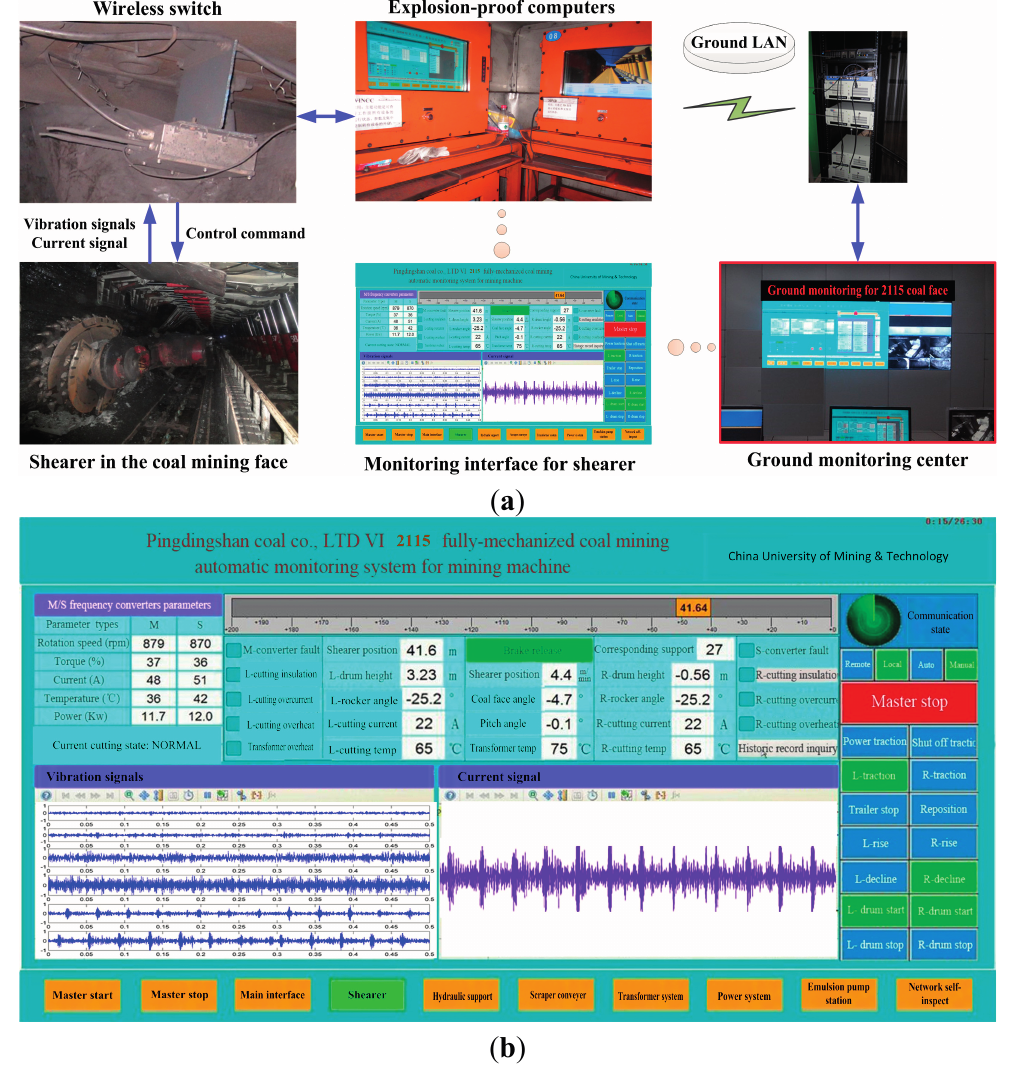
Figure 10. Industrial application example of proposed method: ( a ) The system in coal mining face based on proposed method; ( b ) The monitoring interface for